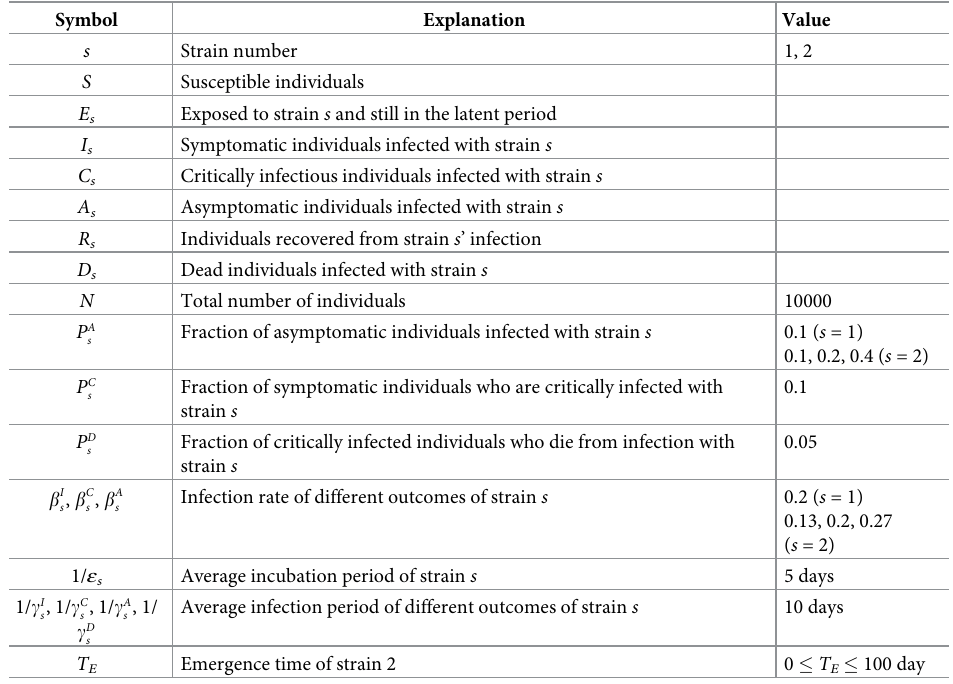
0.1 0.05 0.13, 0.2, 0.27